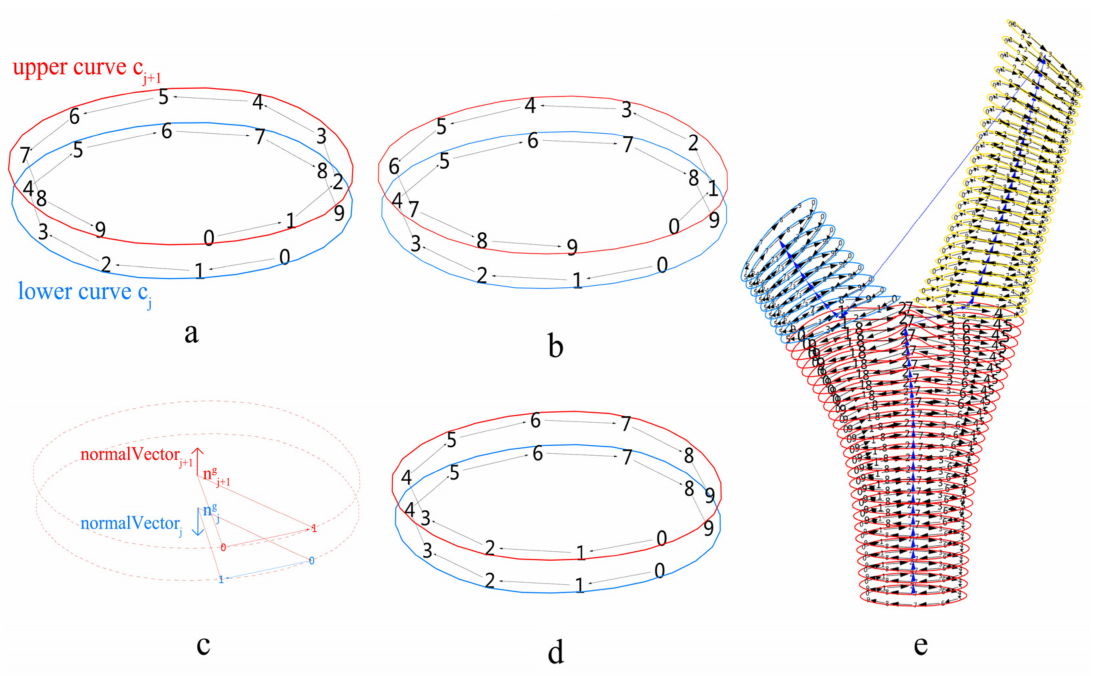
Figure 7. Curve Adjustment: ( a ) original different seams and orientations between upper and lower curve; ( b ) modified seams and orientations with different curve normalVector; ( c ) illustration of curve’s normalVector; ( d ) corrected seams and orientations between upper and lower curve; ( e ) traversed for all curves in this